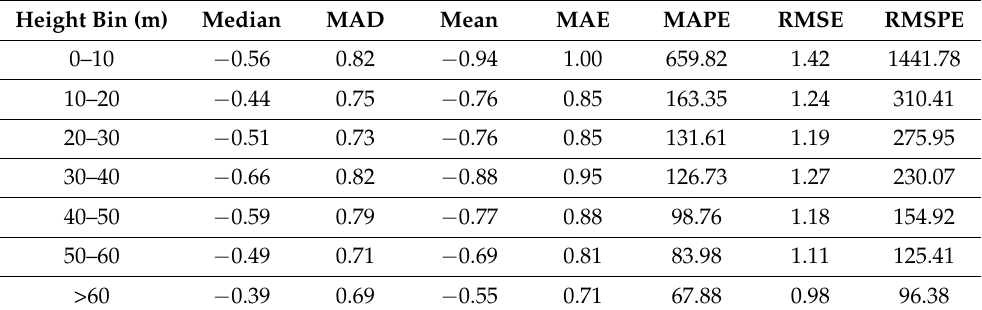
Figure 8. ( a ) Boxplot of overall differences between ALS PAI and GEDI PAI , i.e., (ALS, GEDI) values of PAI for footprints in 7 height bins ( a ) and for footprints in different slope bins ( b ). PAI differences are shown for footprints from the two types of beams (power and coverage). Table 7. Accuracy of GEDI PAI estimates of individual footprints (11,832) for different height bins. Statistics for differences in values (ALS PAI , GEDI PAI ). MAD is median absolute deviation and SD is standard